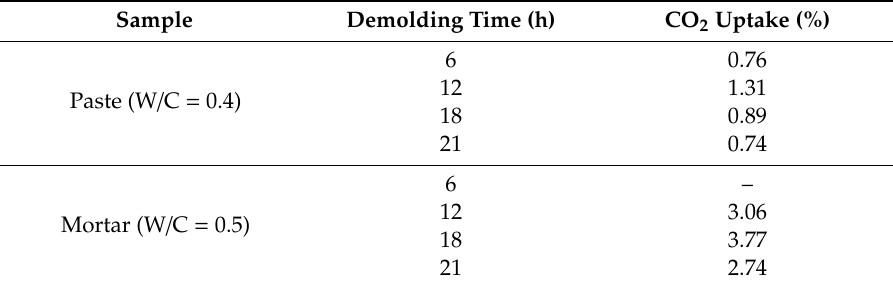
Table 5. CO 2 uptake depending on sealed time.